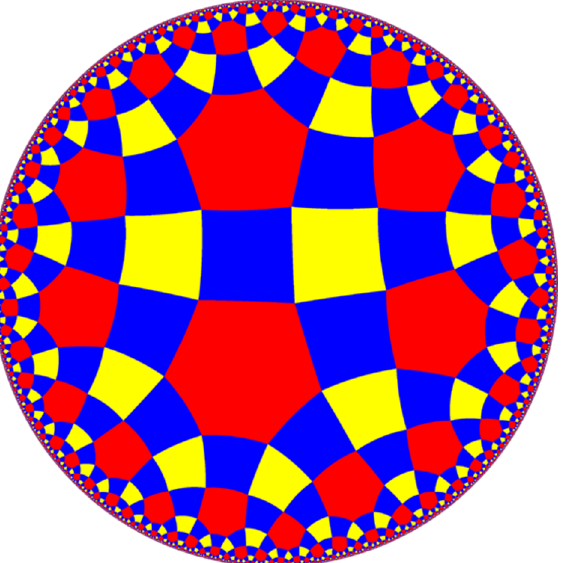
Figure 4 . Tiling of hyperbolic space in the Poincaré disk representation with squares and hexagons. Each vertex is common to exactly three squares and one